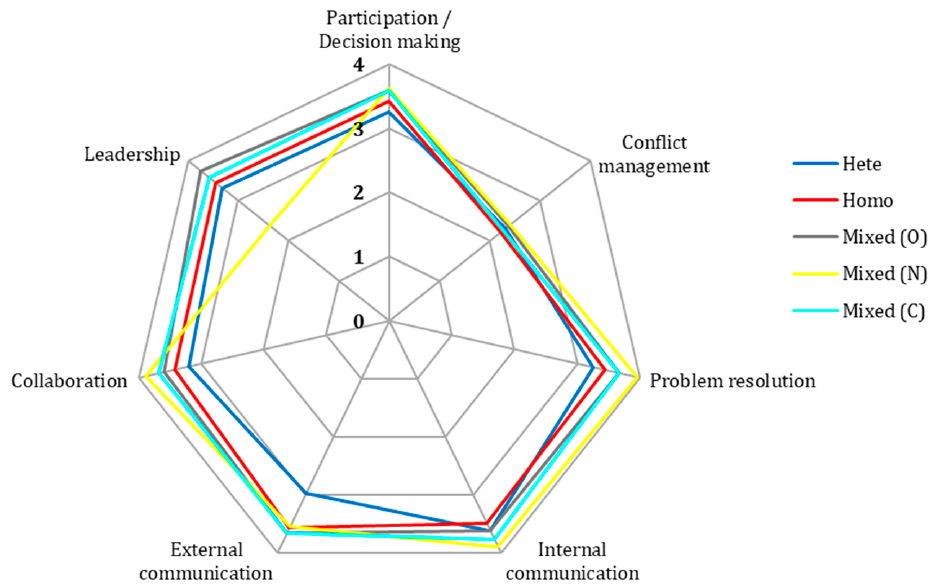
Figure 10. Traces of experimental groups by type of grouping. Table 10. Average scores of the experimentation groups by type of formation.